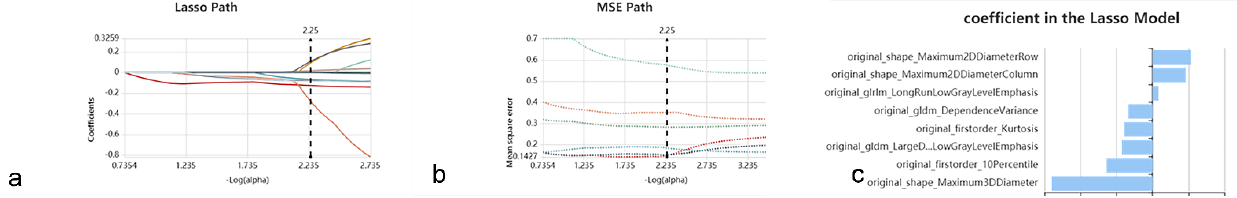
Figure 3. Lasso algorithm on feature selection. ( a ) Lasso path; ( b ) MSE path; and ( c ) coefficients in Lass model. Using the Lasso model, eight optimal features that correspond to the optimal alpha value were selected.